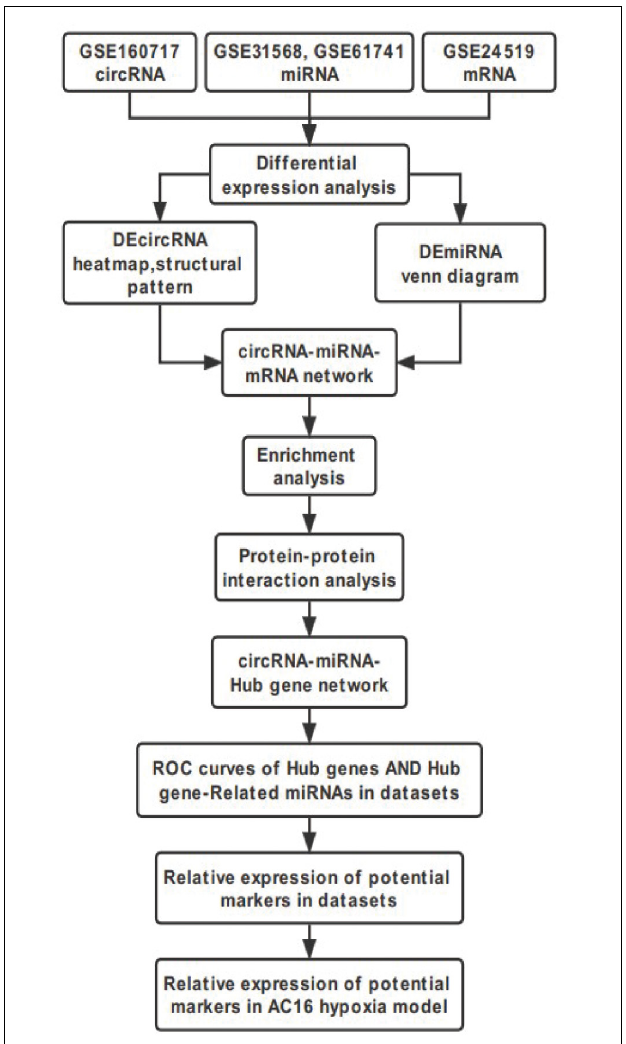
FIGURE 1 | Flowchart of the steps performed in this